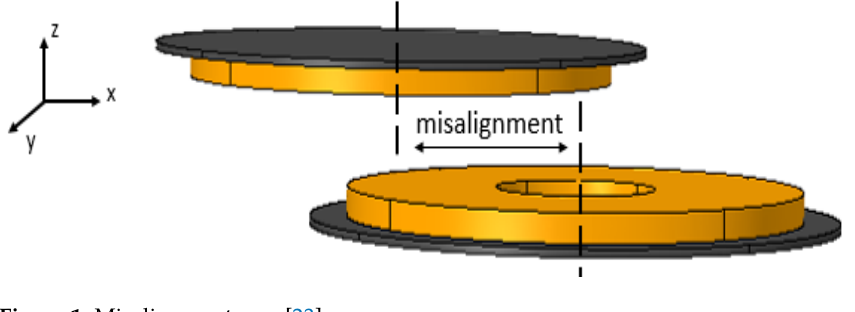
Figure 1. Misalignment case [23].